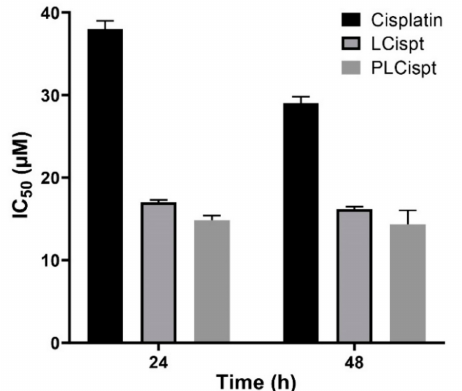
Figure 5. Cytotoxicity e ff ects (IC 50 ) of Cispt, LCispt, and PLCispt after 24 and 48 h incubation. The data are expressed as mean ± SD ( n =